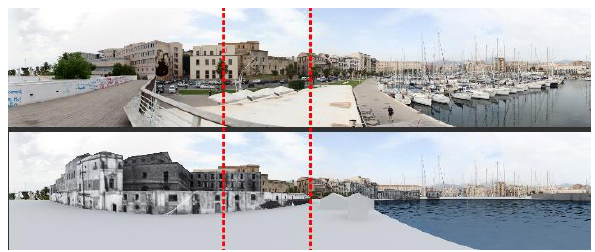
Figure 18: Alignment of Real and mixed panoramic images. Figure 19: Gradual transitions from real to virtual